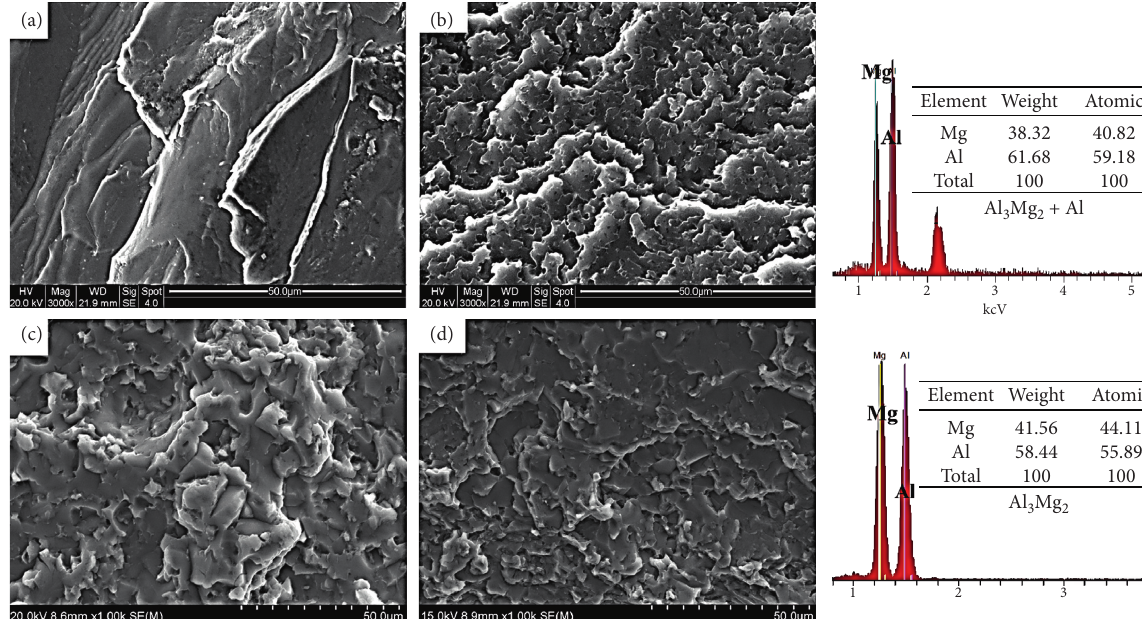
Figure 20: Fracture characteristics along the skins with different traverse speeds: (a) 15mm/min; (b) 30mm/min; (c) 50mm/min; (d)